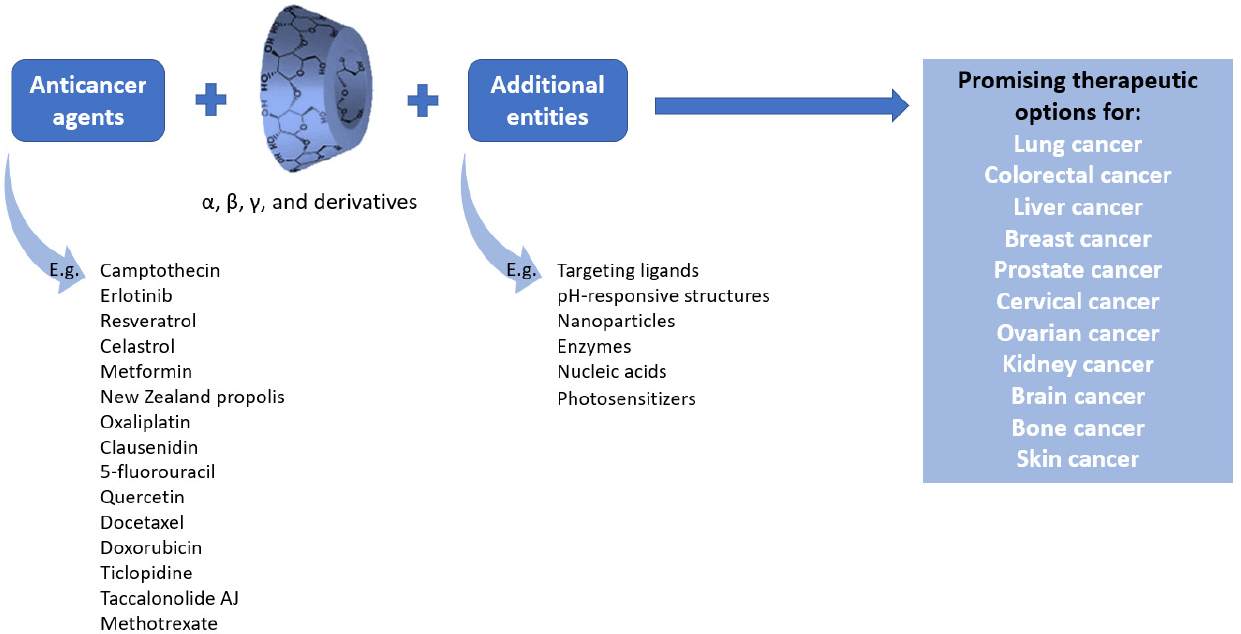
Table 2. Summative table of the discussed CD-based drug delivery systems correlated with the tar- geted types of cancer. CD-Based Nanocarrier(s) Anti-Cancer Agent(s)